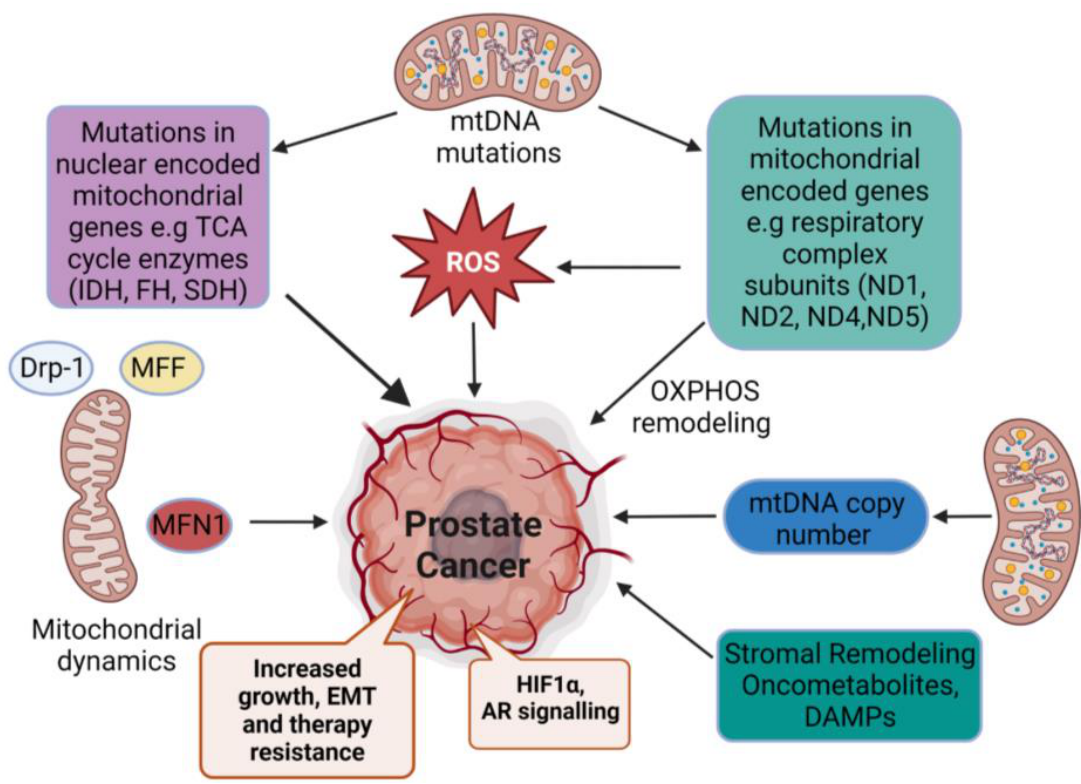
Figure 2. Mitochondrial alterations in prostate cancer and its causative factors. Mitochondrial alter- ations comprise mutations in mtDNA, which can lead to enhanced reactive oxygen species (ROS) production and promote cancer growth and survival. In addition, reprogramming of TCA-cycle metabolites such as citrate and succinate in conjunction with alterations in copy number enable can- cer cells to increase their energy production. Changes in mitochondrial dynamics reshape mitochon- drial metabolism and play an important role in PCa growth, EMT, and therapy resistance. Modula- tion of HIF1α and AR signaling , along with stromal remodeling and oncometabolites, play an im- portant role in progression of PCa. Figure was created with BioRender.com (accessed on 15 Febru- ary 2023).